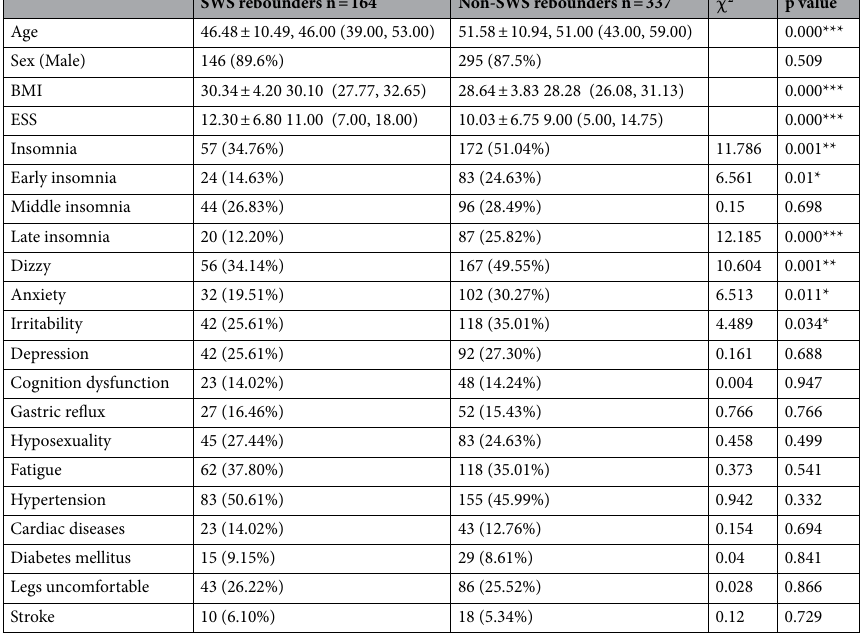
Table 4. Showed the differences of clinical data between SWS rebounders and non-SWS rebounders.